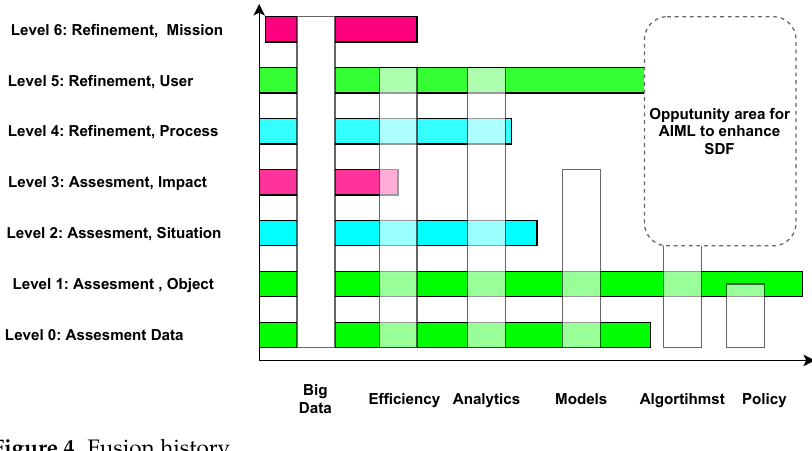
Figure 4. Fusion history. Table 1. Summary of the panel ideas and issues of AI/ML and information